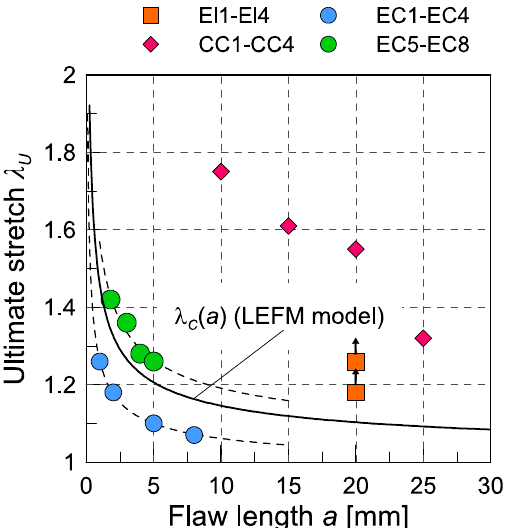
Figure 12. Ultimate remote stretches at failure λ U as a function of the initial crack length a . In the case of the elliptical notches, the upward arrows indicate that failure has not occurred within the considered range of applied stretch. The continuous line corresponds to the prediction of the ‘pure’ LEFM solution, Equation (15). The dashed lines correspond to best-fit curves with a λ U vs. a power law dependence with exponent − 0.5. Results for EC1–EC4 for a strain rate